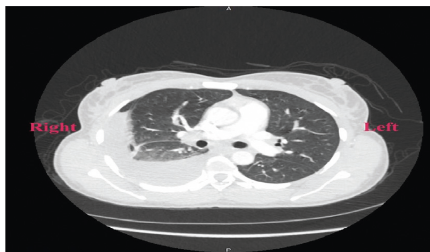
Figure 1: Computed tomography of the chest without contrast. Moderate right pleural effusion with passive atelectasis of the right middle and lower lobes; bilateral hilar lymphadenopathy; perihepatic ascites.